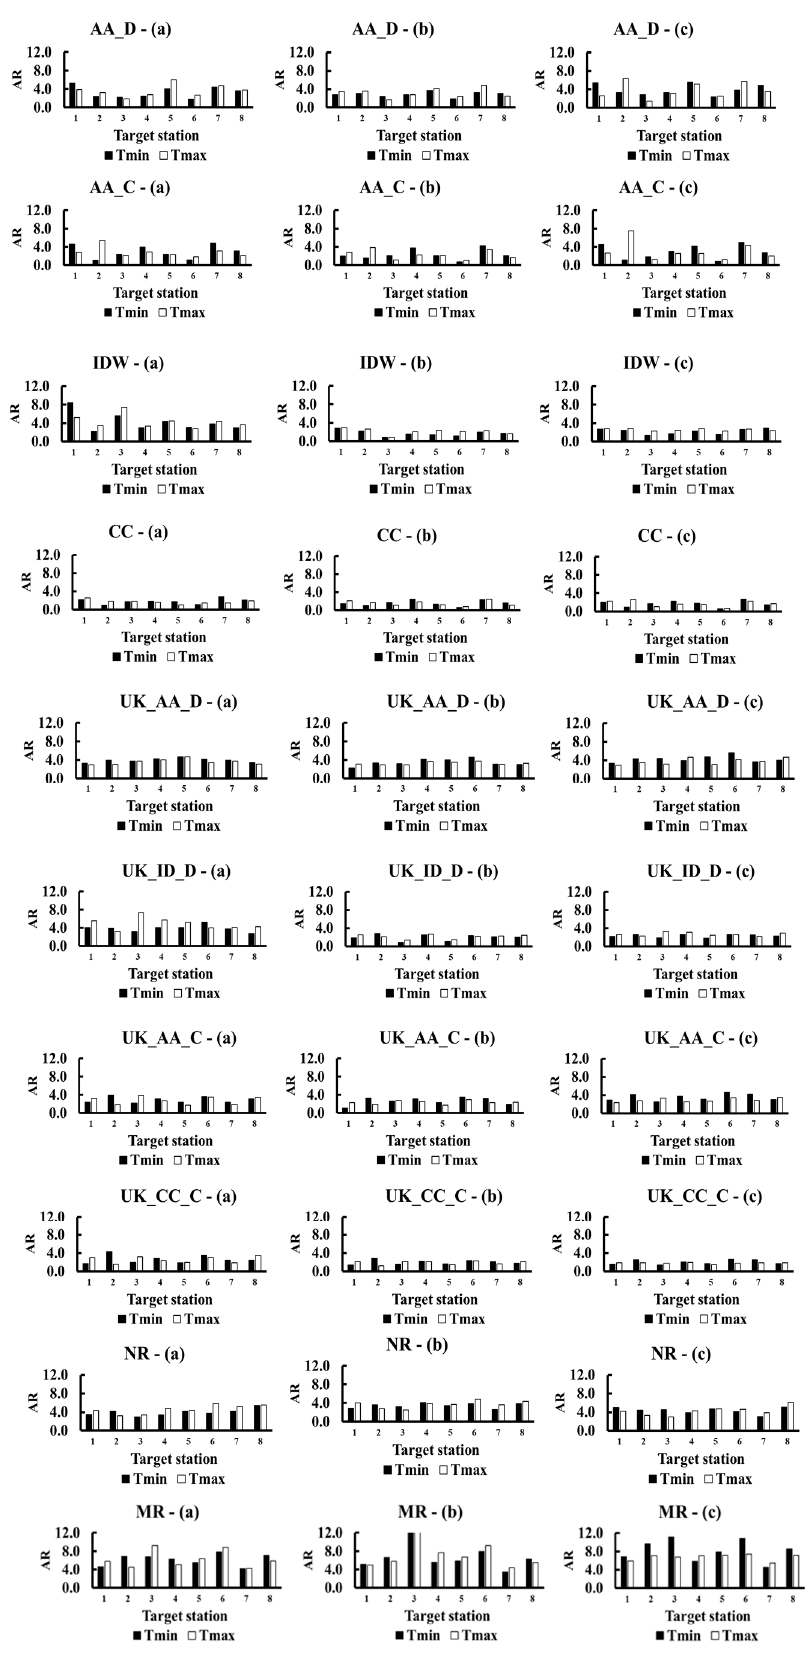
Figure 6. Accuracy rate (AR) for estimating minimum and maximum temperatures for each infilling method at all target stations using ( a ) three target stations, ( b ) 5 target stations and ( c ) 8 target stations.